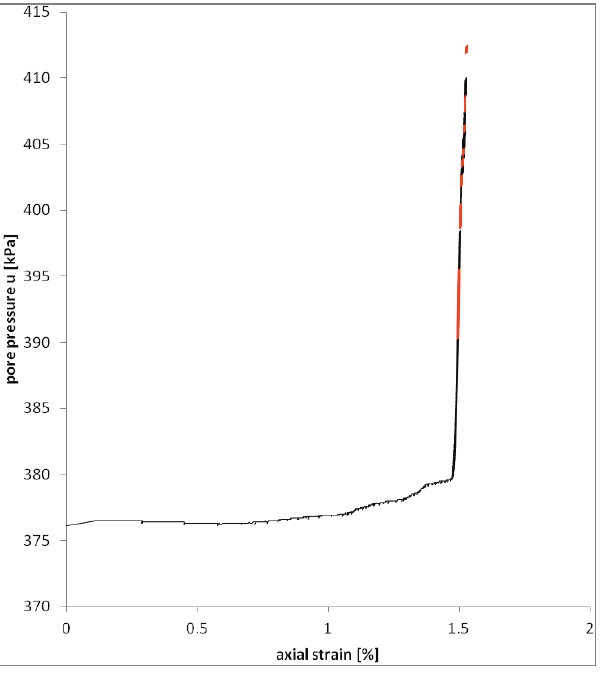
Fig. 2. Plot of pore pressure u evolution during repeated loading triaxial test on sandy-silty clay sample